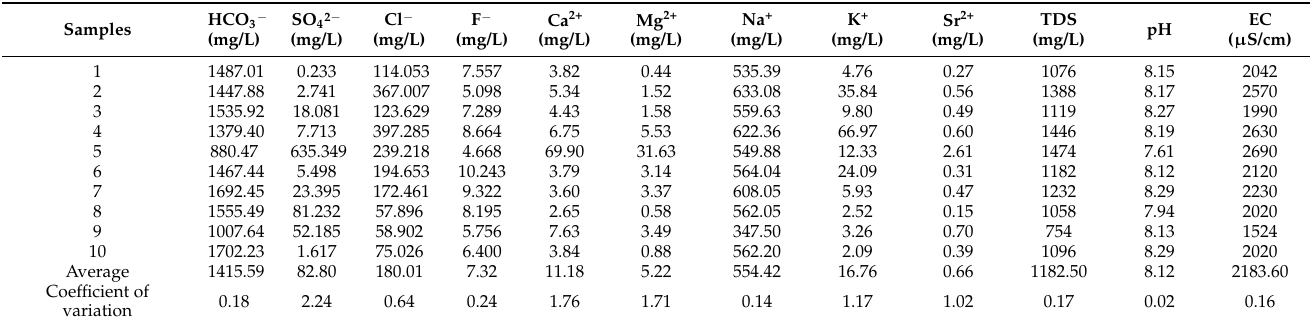
Table 1. Ionic compositions and parameters of produced water